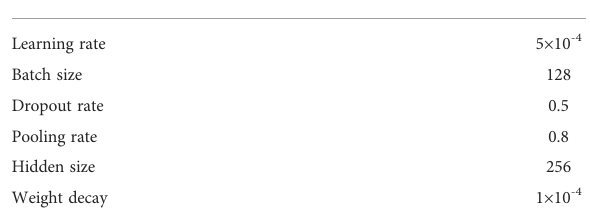
TABLE 1 The main parameters of GCN